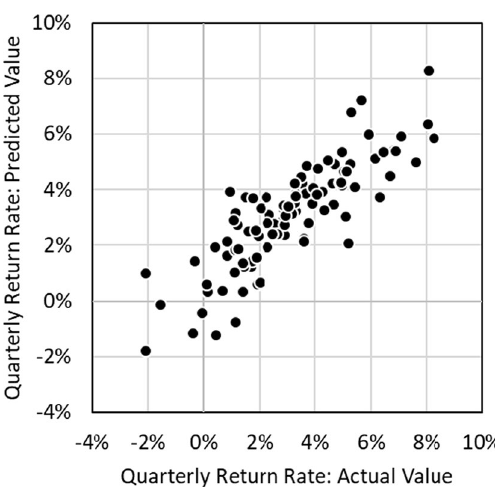
Fig. 39 Actual and predicted values of the quarterly return rate in the t